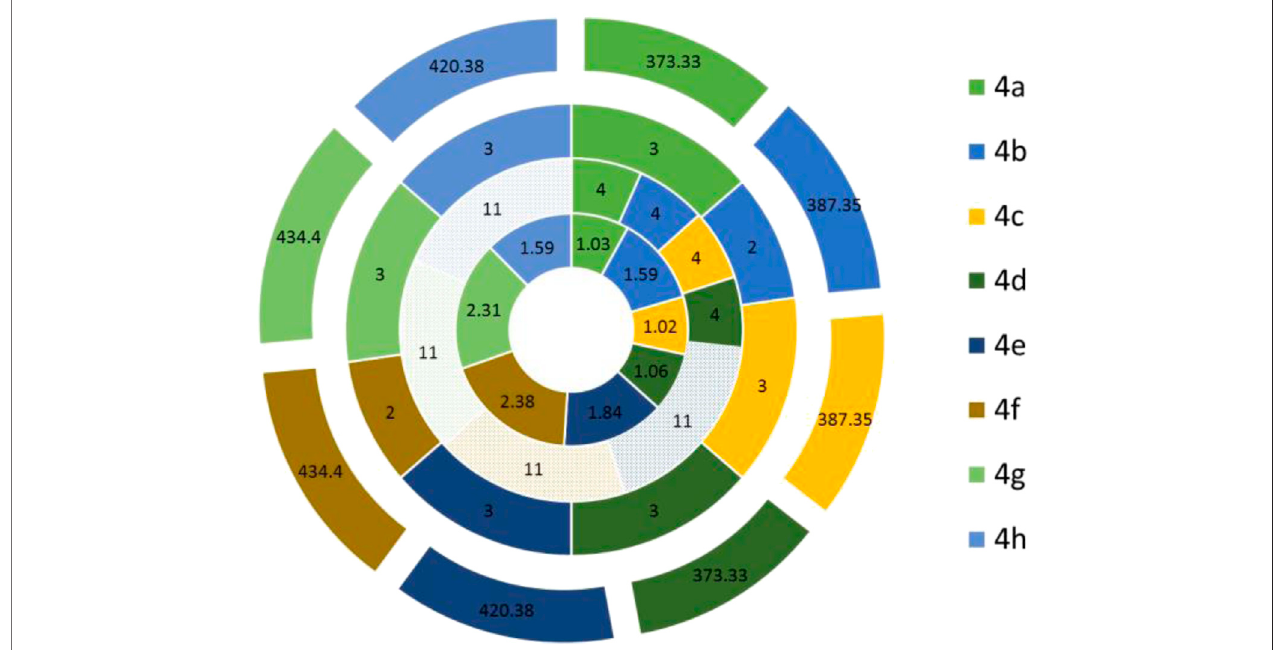
FIGURE 4 | Predicted parameters of Lipinski ’ s rule of fi ve for the synthesized compounds were calculated using SwissADME and represented in the Doughnut graph. The compounds that violate the rule were represented in the fi lled pattern format. Each circle represents one parameter of Lipinski ’ s rule. The parameters LogP, HBA, HBD, and MW showed from inner to outer circles,